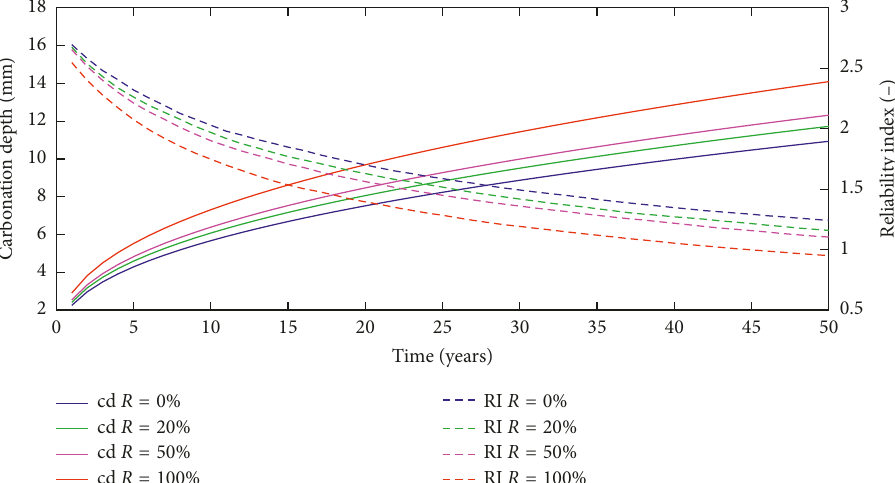
Figure 2: Carbonation depth (continuous line) and reliability index (dashed line) versus service life-XC2 exposure class: w/c �